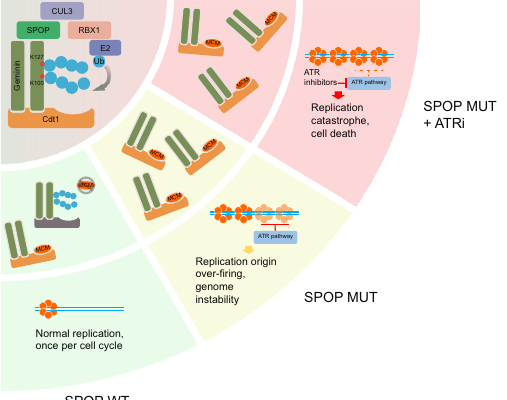
Fig. 7 A hypothetical model depicting how SPOP mutation impairs DNA replication and sensitizes cancer cells to ATR inhibition. a SPOP-CUL3- RBX1 functions as an E3 ubiquitin ligase that binds to Geminin and catalyzes K27-linked poly-ubiquitination of Geminin at Lys100 and Lys127. b SPOP- dependent Geminin poly-ubiquitination blocks Cdt1 binding to MCM proteins. Poly-ubiquitination keeps the licensing-competent state in check and prevents DNA replication over- fi ring. c Cancer-associated SPOP mutations impair DNA replication surveillance and cause replication origin over- fi ring and re-replication. d SPOP mutations trigger replication catastrophe and cancer cell death upon ATR Whole-genome and exome sequencing of cancer patient samples have shown that SPOP is the most frequently mutated gene in primary prostate cancer 27,28 , suggesting that patients with SPOP mutations represent an important subtype of prostate cancer. SPOP mutations typically occur in a heterozygous state with a retained wild-type allele and are able to dysregulate known substrates in a dominant-negative manner 32,33,58 . Our fi nding also con fi rmed the dominant-negative effect of SPOP mutations. Almost all mutants lost the ability to bind and ubiquitinate Geminin even though endogenous SPOP is present (Fig. 3d, e). Increasing evidence indicates that SPOP targets a large spectrum of protein substrates for degradation, which implies that dysregulation of different downstream signaling pathways would require different therapeutic strategies for SPOP-mutated patients. Indeed, it has been shown that cells expressing prostate cancer-derived SPOP mutants are